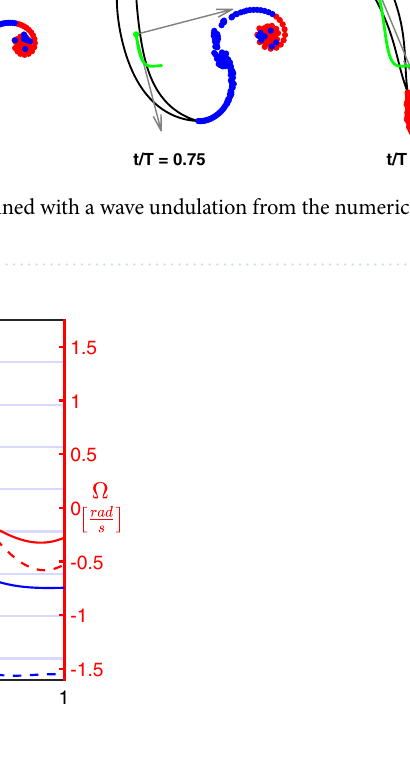
Figure 7. Comparison between forward and angular velocity components for the C-start maneuver with and without wave